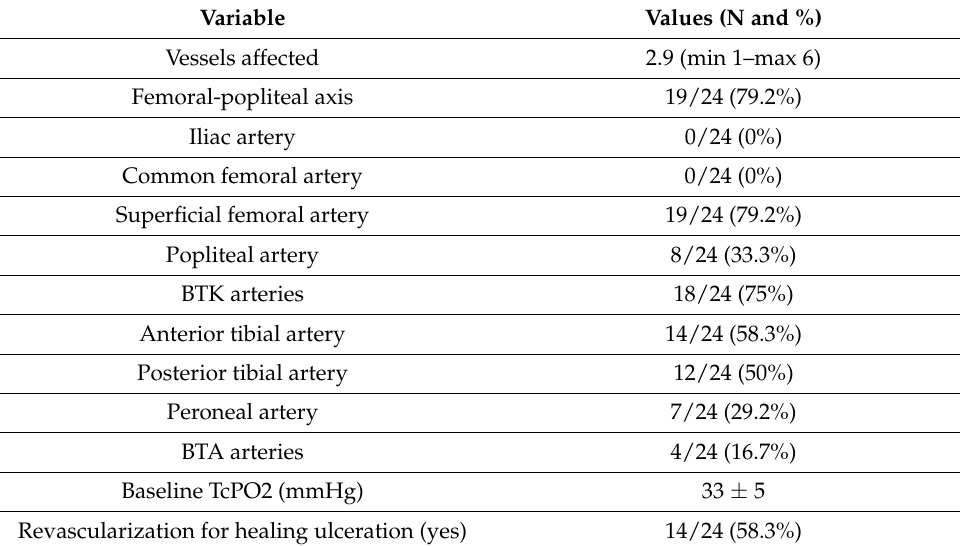
Table 5. Characteristics of PAD in patients with CN and